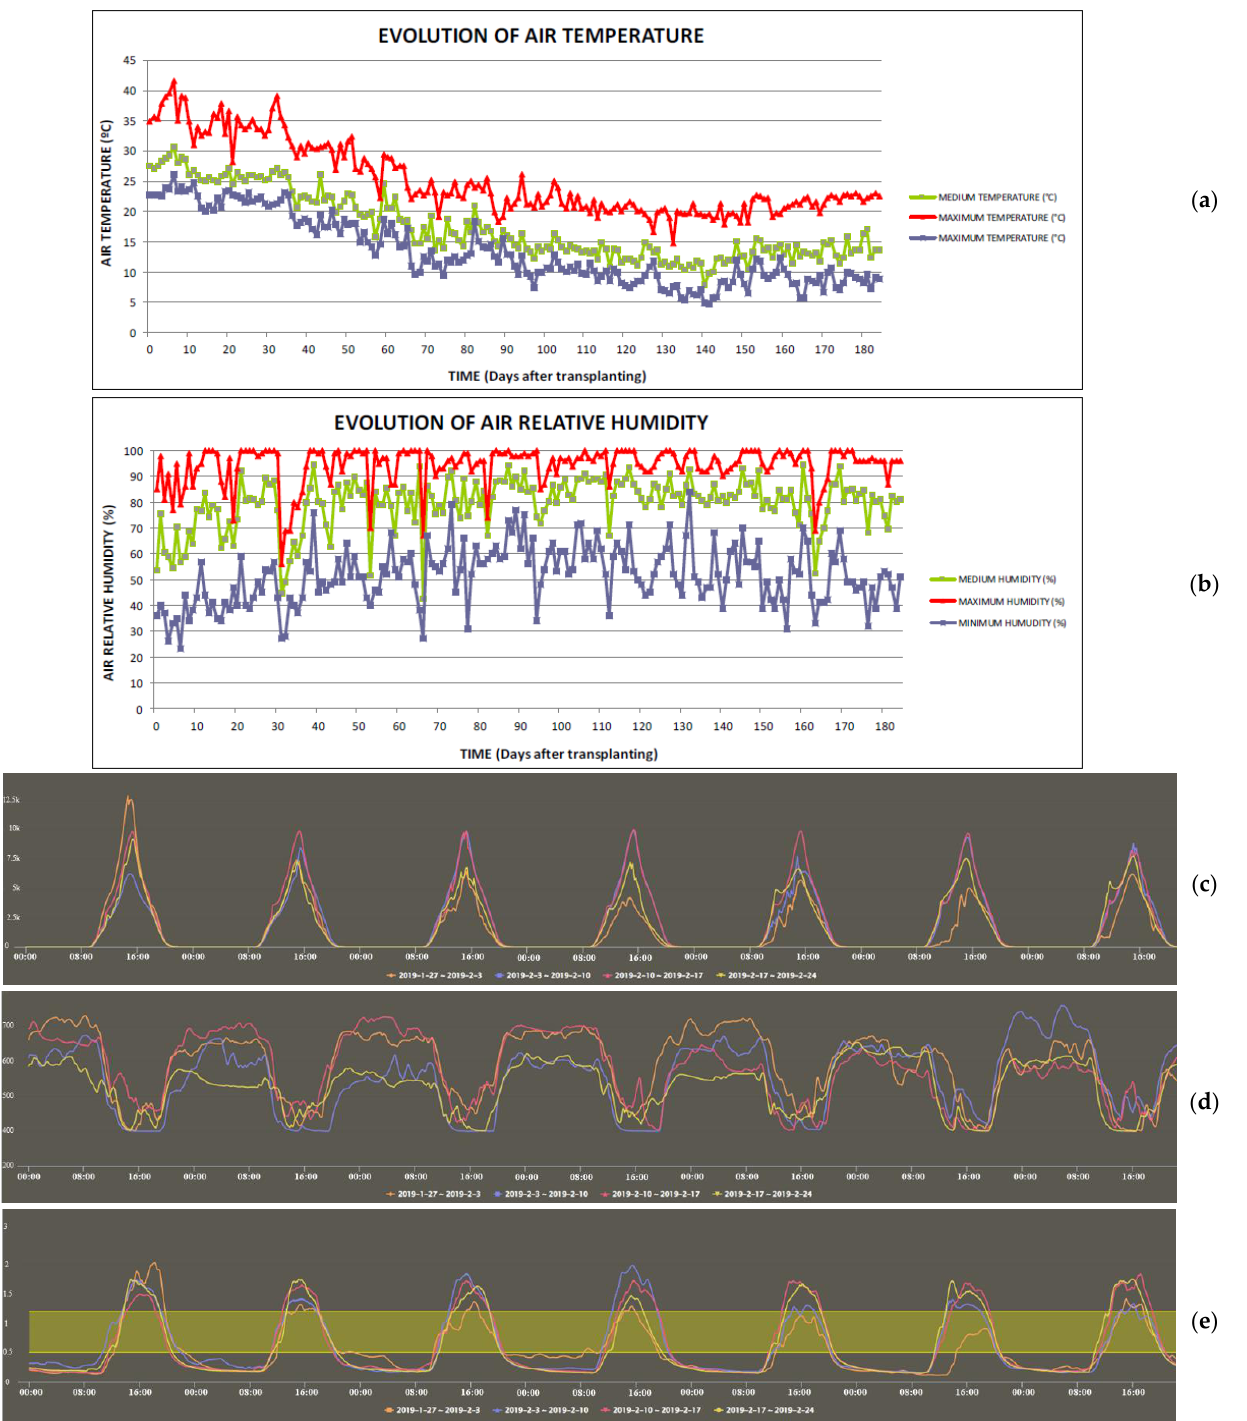
Figure 3. Evolution of ( a ) the air temperature; ( b ) the air relative humidity; ( c ) the illumination; ( d ) the air CO 2 concentration; ( e ) the air VPD condition inside the greenhouse during the field trial.